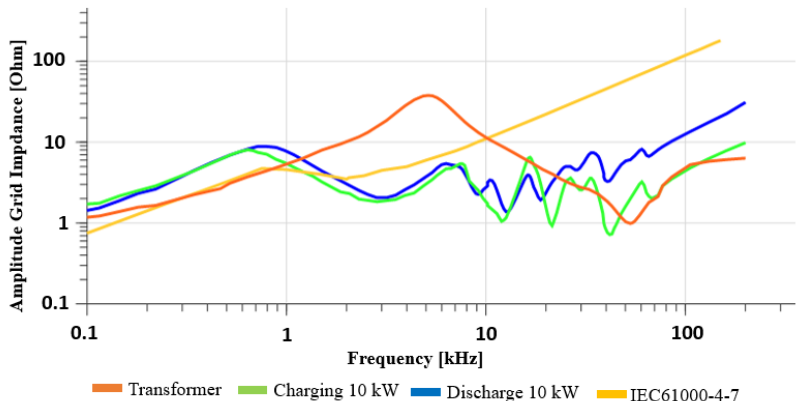
Figure 16. Amplitude of the frequency-dependent grid impedance from 100 Hz to 150 kHz.